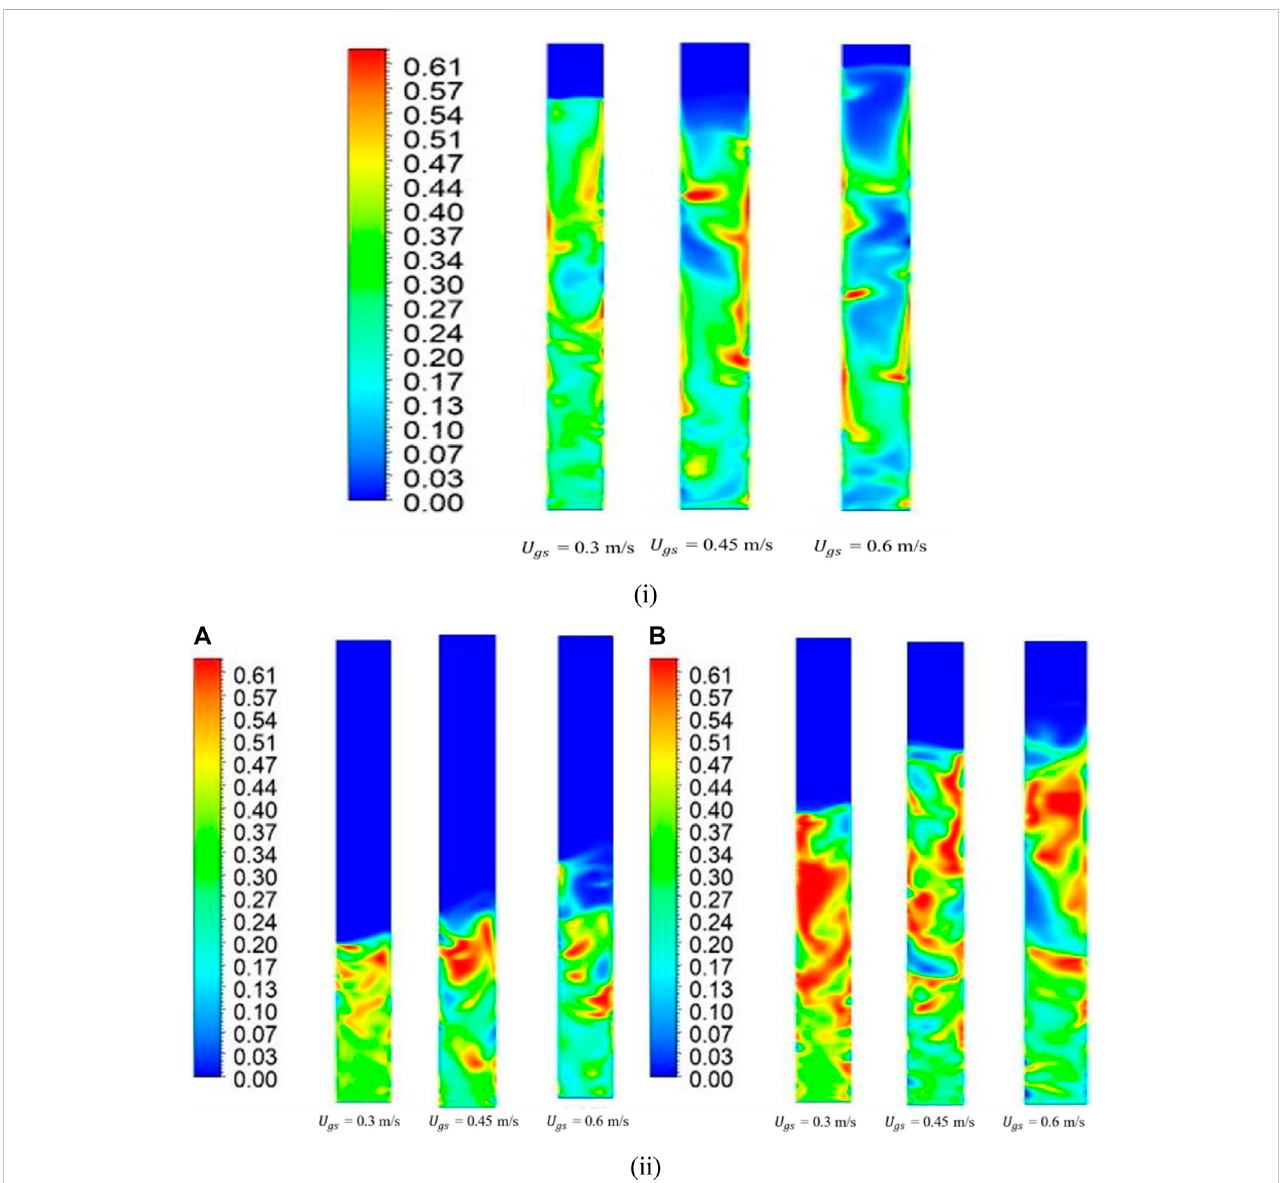
FIGURE 7 Time-averagedsteady-statesolid-phasevolumefractioncontoursfor (i) 0%mixtureat0.635 mbedheightand (ii) 20%mixtureat (A) 0.335 mbedheight and (B) 0.635 m bed